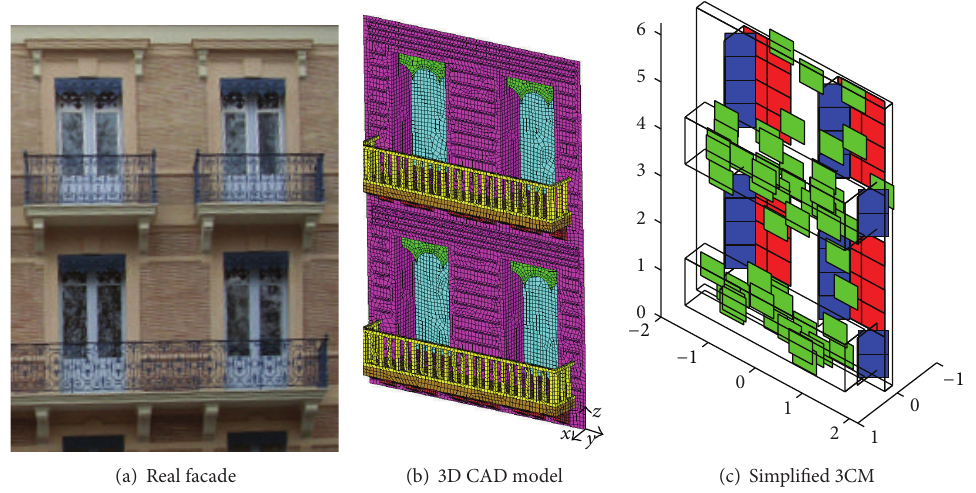
Figure 9: Three different representations of one complex city center